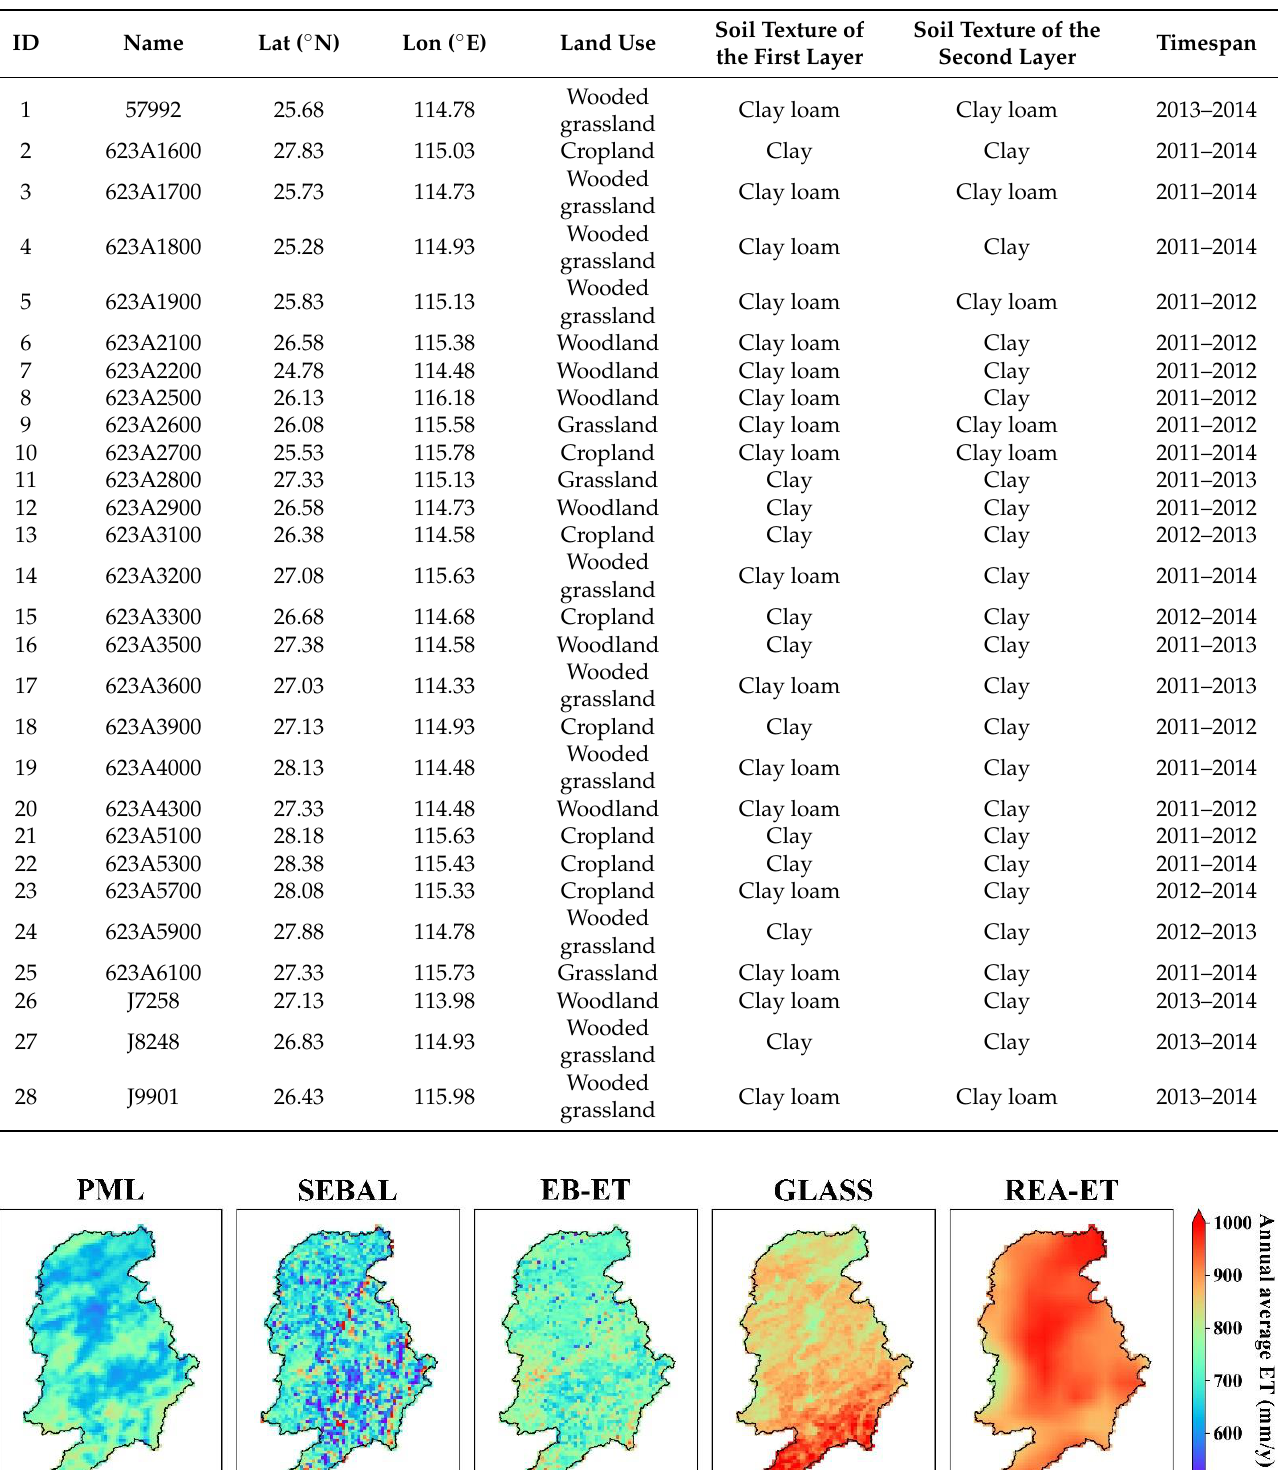
Table 2. Summary of 28 soil moisture stations.